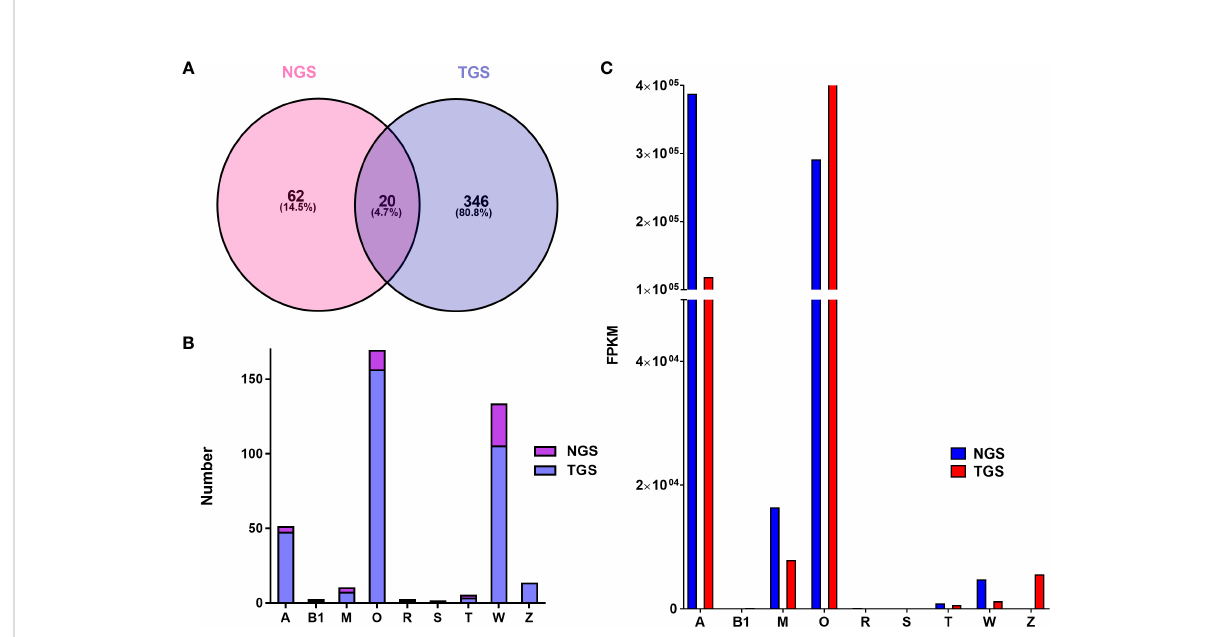
FIGURE 4 Comparison of conotoxin transcripts from the NGS and TGS datasets. (A) Relationship of the identi fi ed conotoxins from the NGS and TGS datasets. (B) Subdivision of conotoxin superfamilies from the NGS and TGS datasets. (C) Transcription of the NGS- and TGS-derived conotoxin superfamilies in C striatus. .